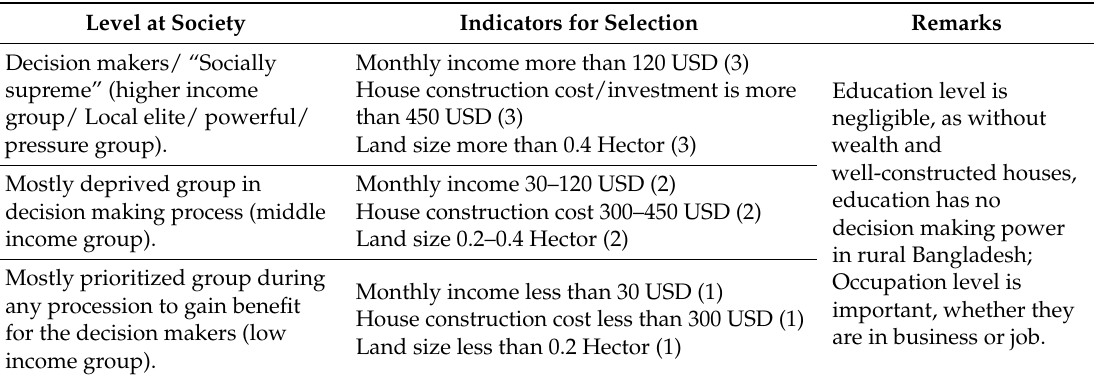
Table 1. Social supremacy index